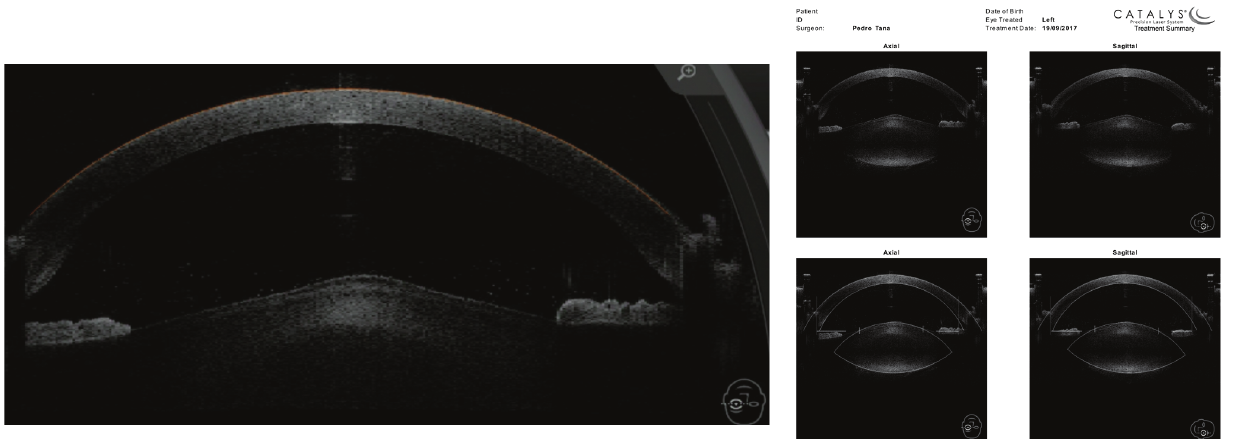
Figure 5. Intraoperative images confirming the presence of an anterior lenticonus in the anterior segment optical coherence tomography imaging